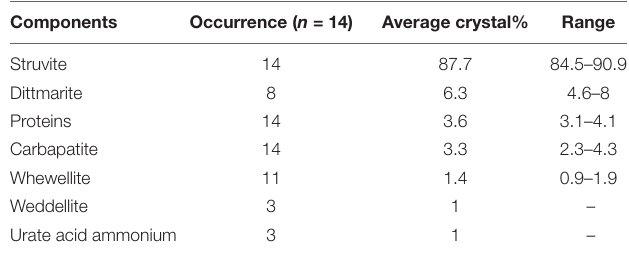
TABLE 3 | Component proportion of Vaginal calculi as revealed by FTIR spectroscopy ( n =